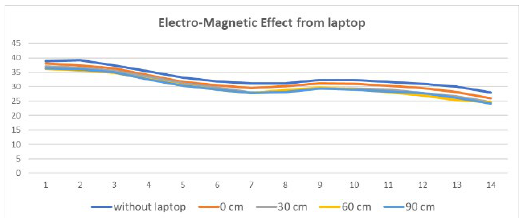
Figure 11. The comparison of magnitude